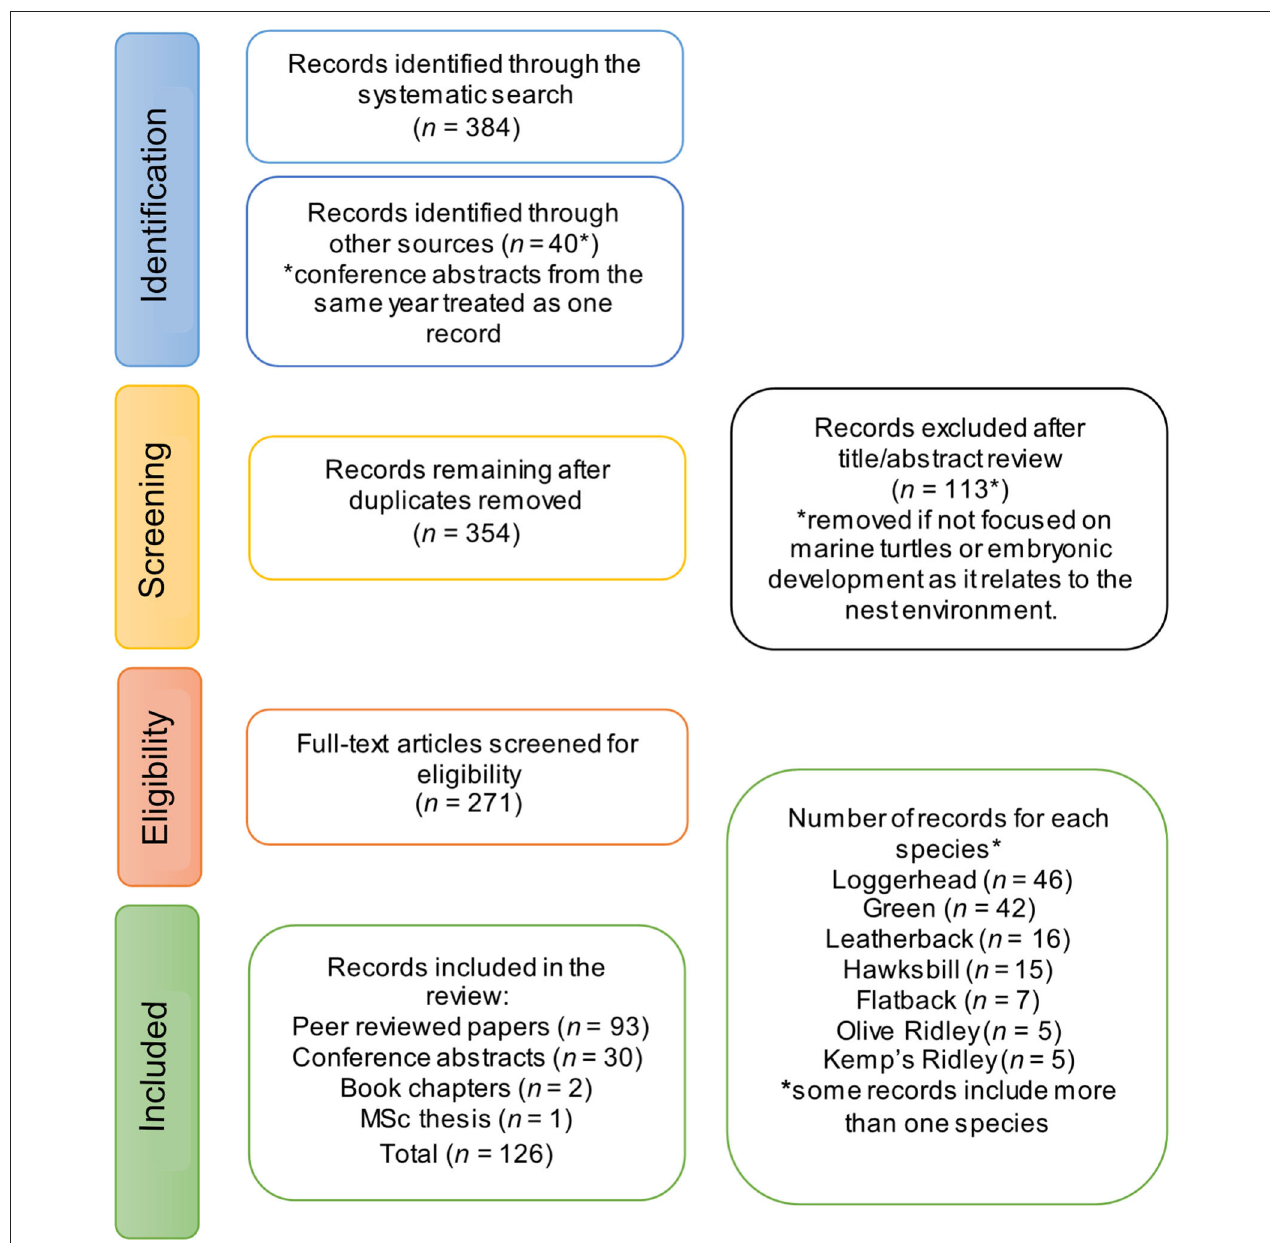
FIGURE 1 | PRISMA Flow diagram of the study selection process for this systematic literature review.